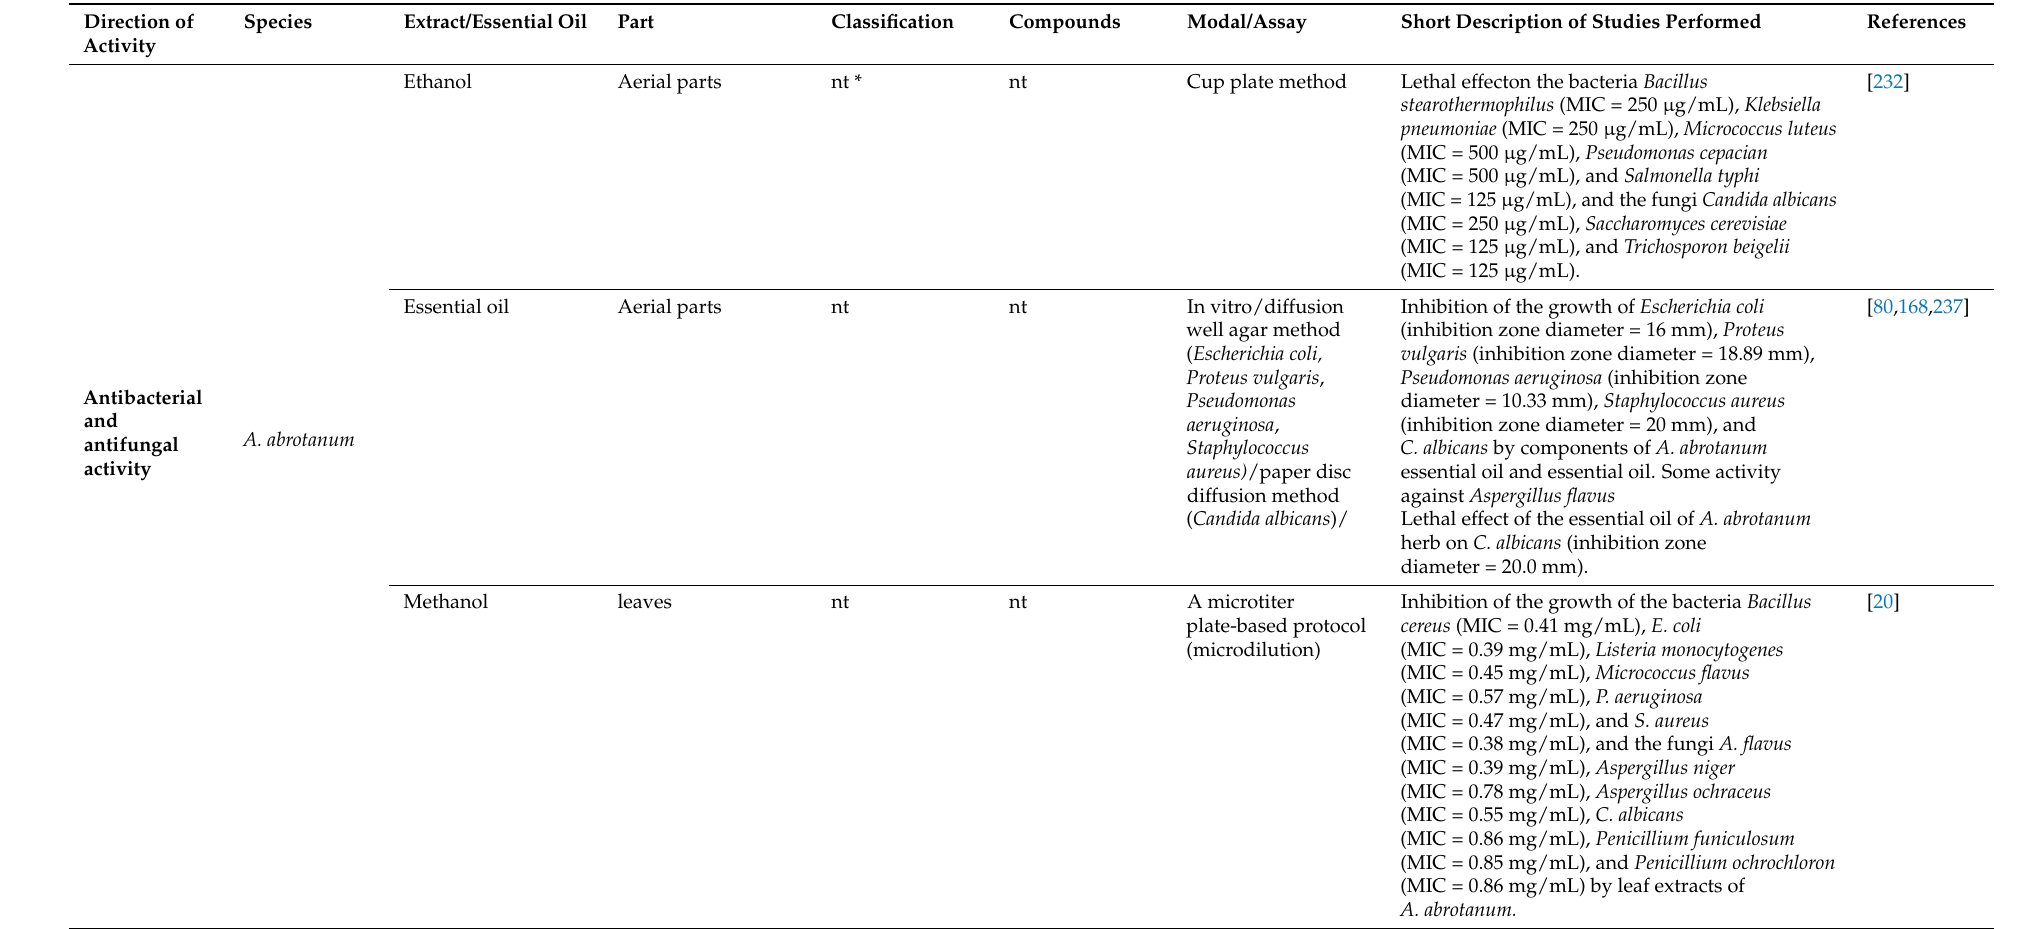
Table 7. Cosmetic and potentially cosmetic properties of Artemisia